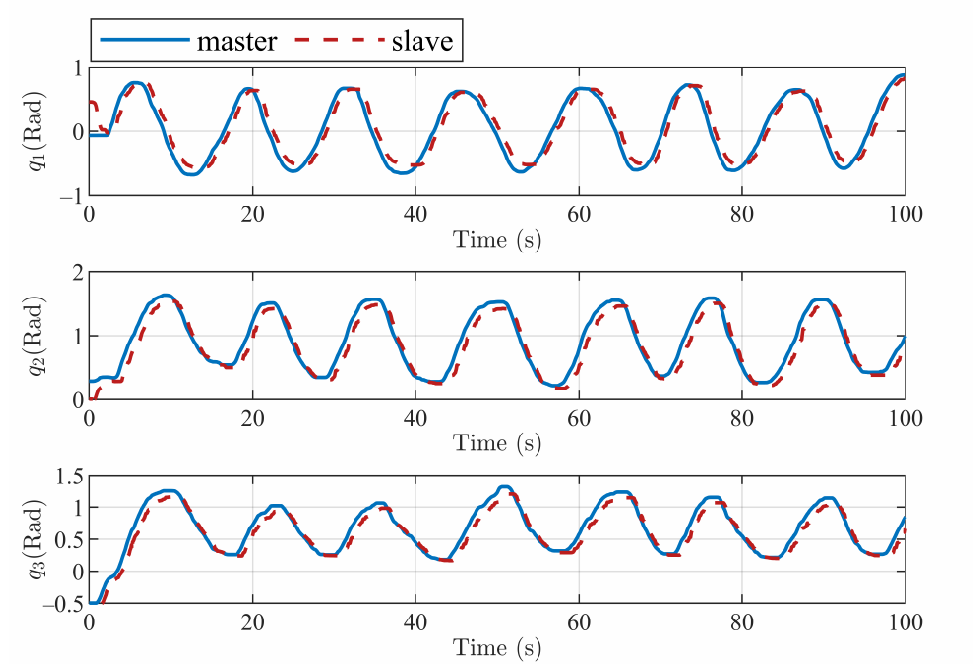
Figure 13. Tracking control performance of three active joints of master and slave robots under experiment case